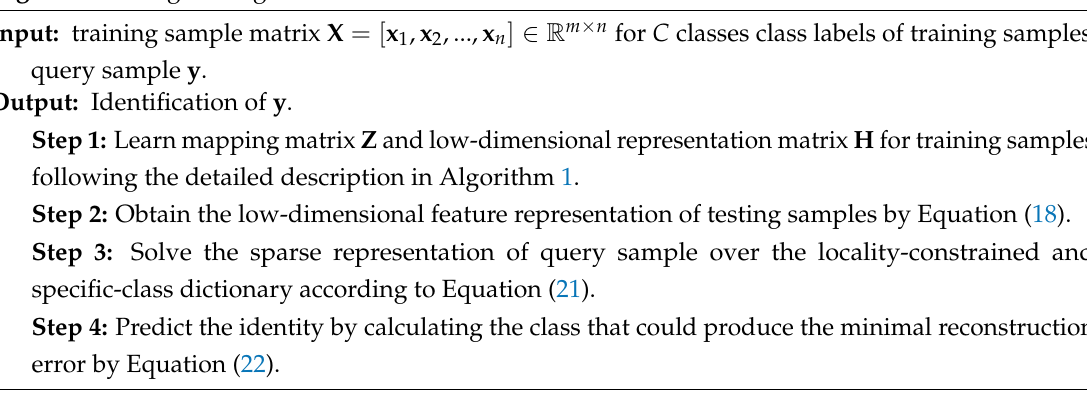
Algorithm 2 Target recognition via MLA-LSR